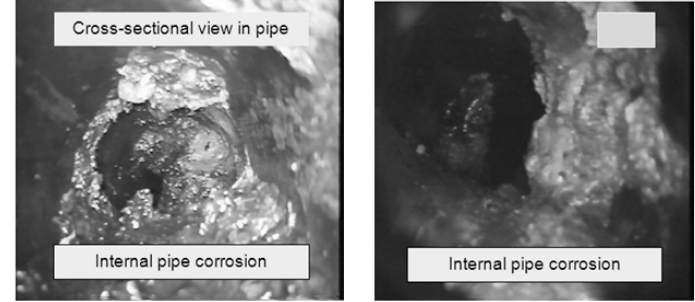
Figure 2. Cross-sectional views of aged water pipelines (adapted from [4]).